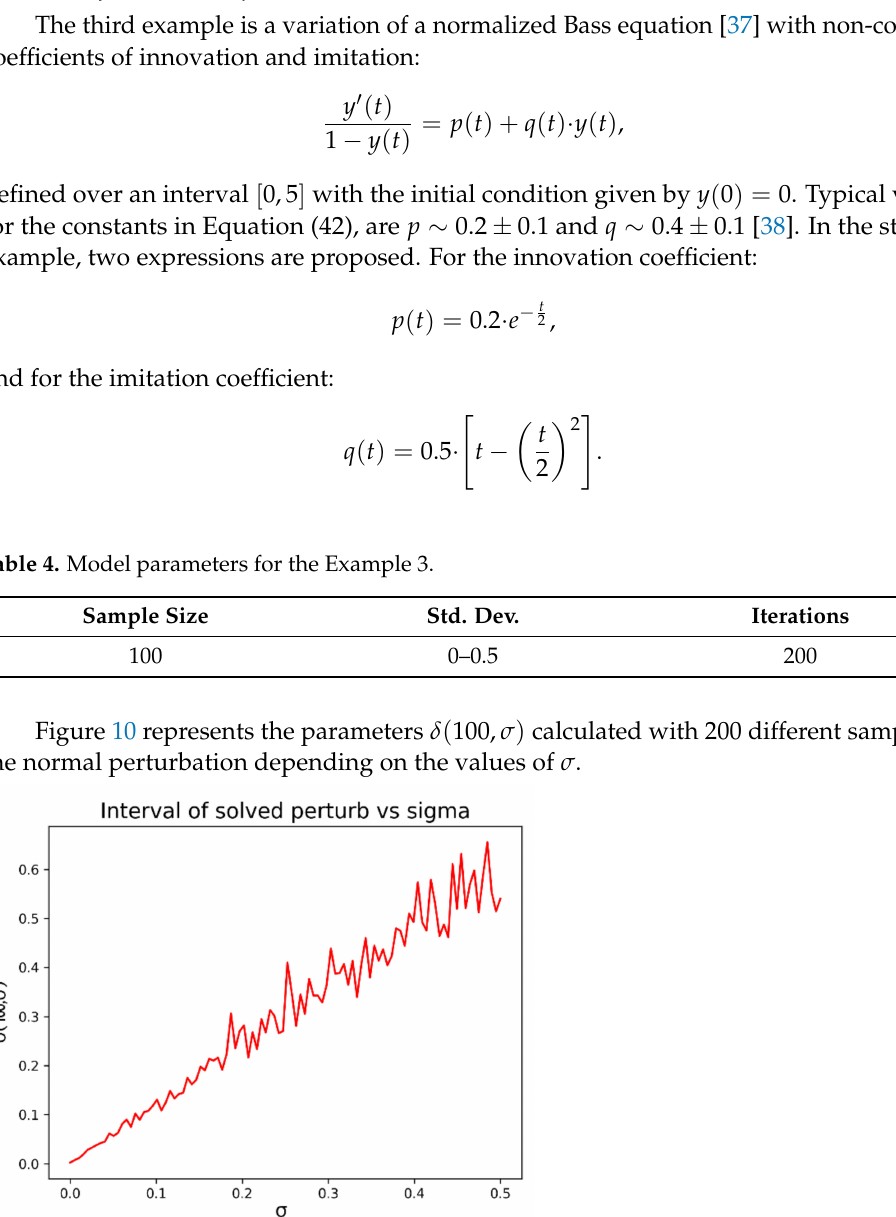
Figure 10. Effect on the solution of different standard deviation for 200 samples of the normal perturbation term for the parameters δ ( 100, σ )